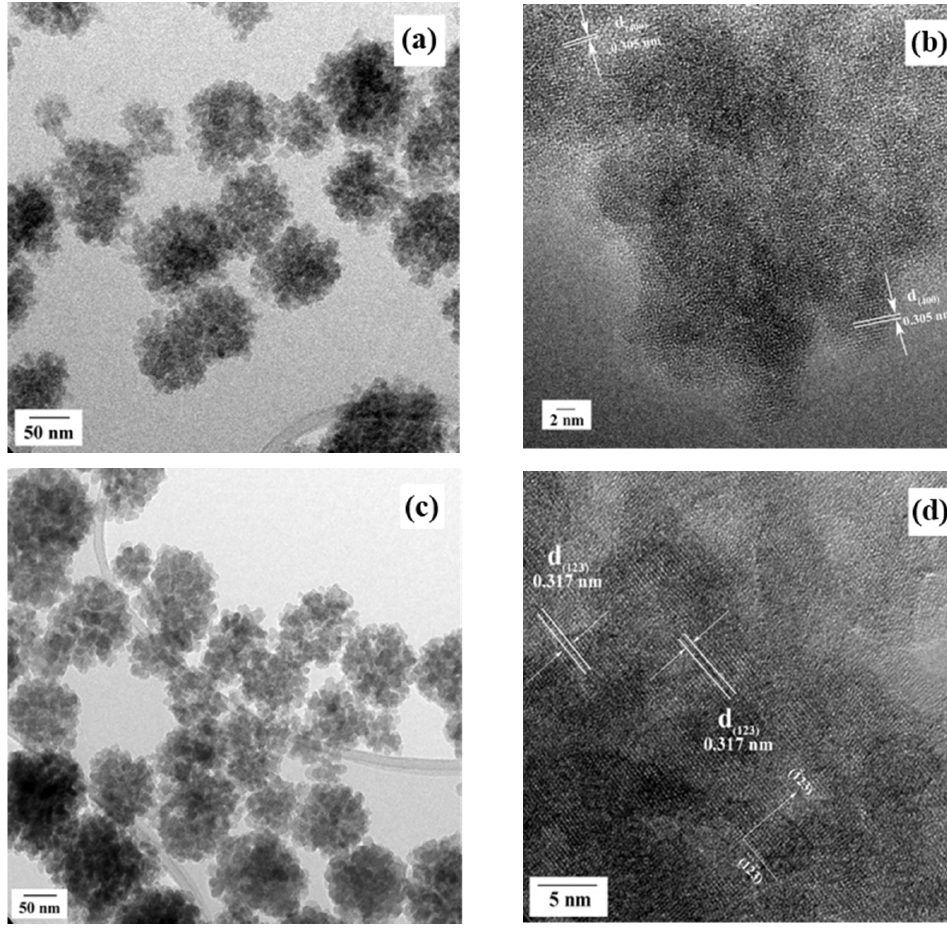
Figure 6. TEM ( a , c ) and HR-TEM ( b , d ) images of the popcorn shaped Ca 3 Cr 2 Si 2 O 12 agglomerates hydrothermally prepared for 72 h without autoclave stirring and 3.0 mole Si 4+ content using 12.5 mL of 5.0 M KOH as solvent. The one-pot hydrothermal treatment was carried at 200 ( a , b ) and 240 °C ( c , d ), respectively.